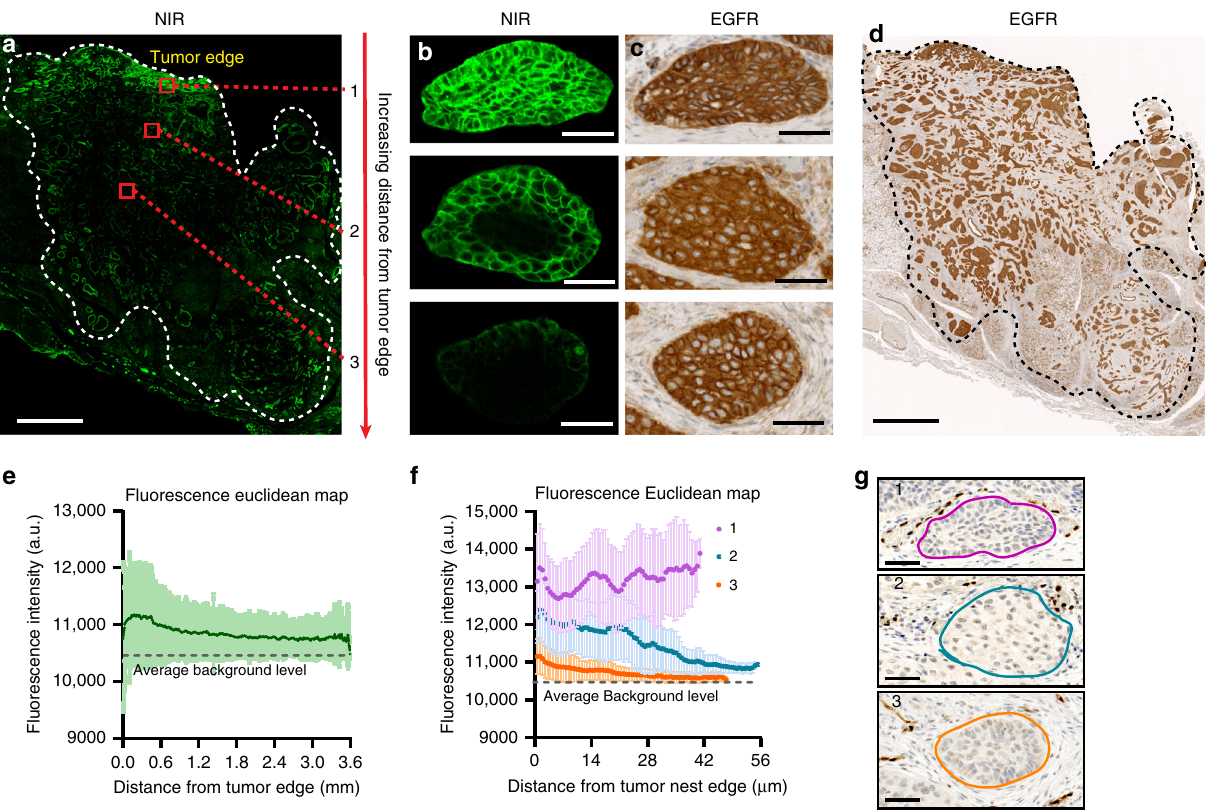
Fig. 3 Antibody – dye distribution demonstrated both macroscopic and microscopic heterogeneity within the solid tumor. a Antibody – dye uptake (NIR: near-infrared) was higher in the tumor periphery or edge (especially the epithelium) than that in the tumor interior (Scale bar: 2 mm). b , c Antibody penetrated deeper into tumor nests located close to the edge of the bulk tumor than tumor nests located further away from the tumor edge, which was not attributable to EGFR (epidermal growth factor receptor) expression (Scale bar: 50 μ m). d EGFR expression level is similar across the entire tumor (Scale bar: 2 mm). e The fl uorescence intensity negatively correlated with increasing distance from the edge of the bulk tumor. f The fl uorescence intensity plot depicted varying degree of antibody penetration into tumor nests: 1. fully saturated tumor nests at the periphery; 2. partially saturated tumor nests; 3. poorly penetrated tumor nests at the center of the tumor. (The shaded area in e and f means standard deviation). n = 3 tumor nests from the same patient. g Vessel staining (ERG) corresponding to region 1, 2, 3 in f (Scale bar: 50 μ